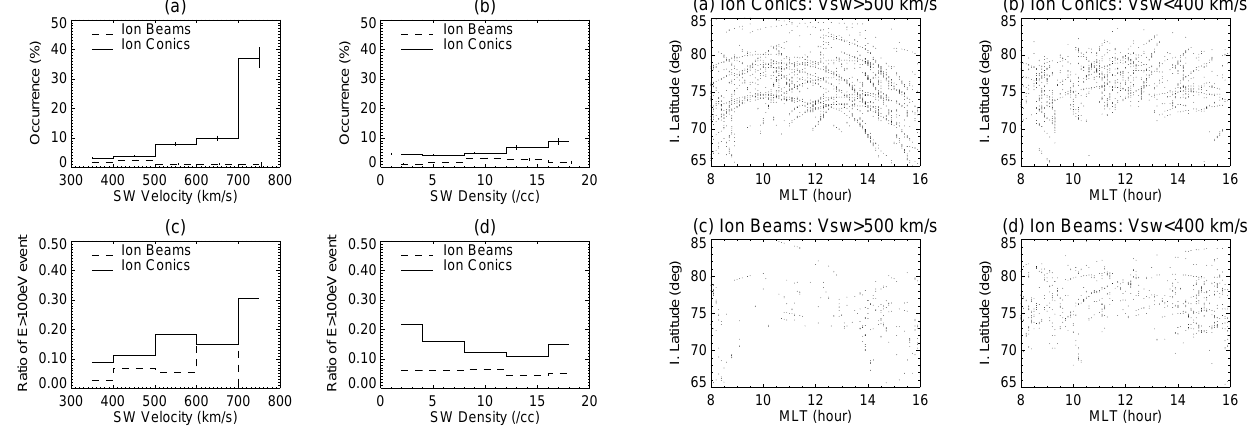
Fig. 4. Occurrence frequency of ion beams and conics as a function of (a) solar wind velocity and (b) solar wind density and ratio of the energetic ( > 100eV) event to the total event number as a function of (c) solar wind velocity and (d) solar wind density. The occur- rence frequency is integrated over the entire altitude ( < 10000km), invariant latitude (65 ◦ –85 ◦ ), and MLT (9–15h) ranges. The vertical bar in Figs. 4a and 4b is the statistical uncertainty.